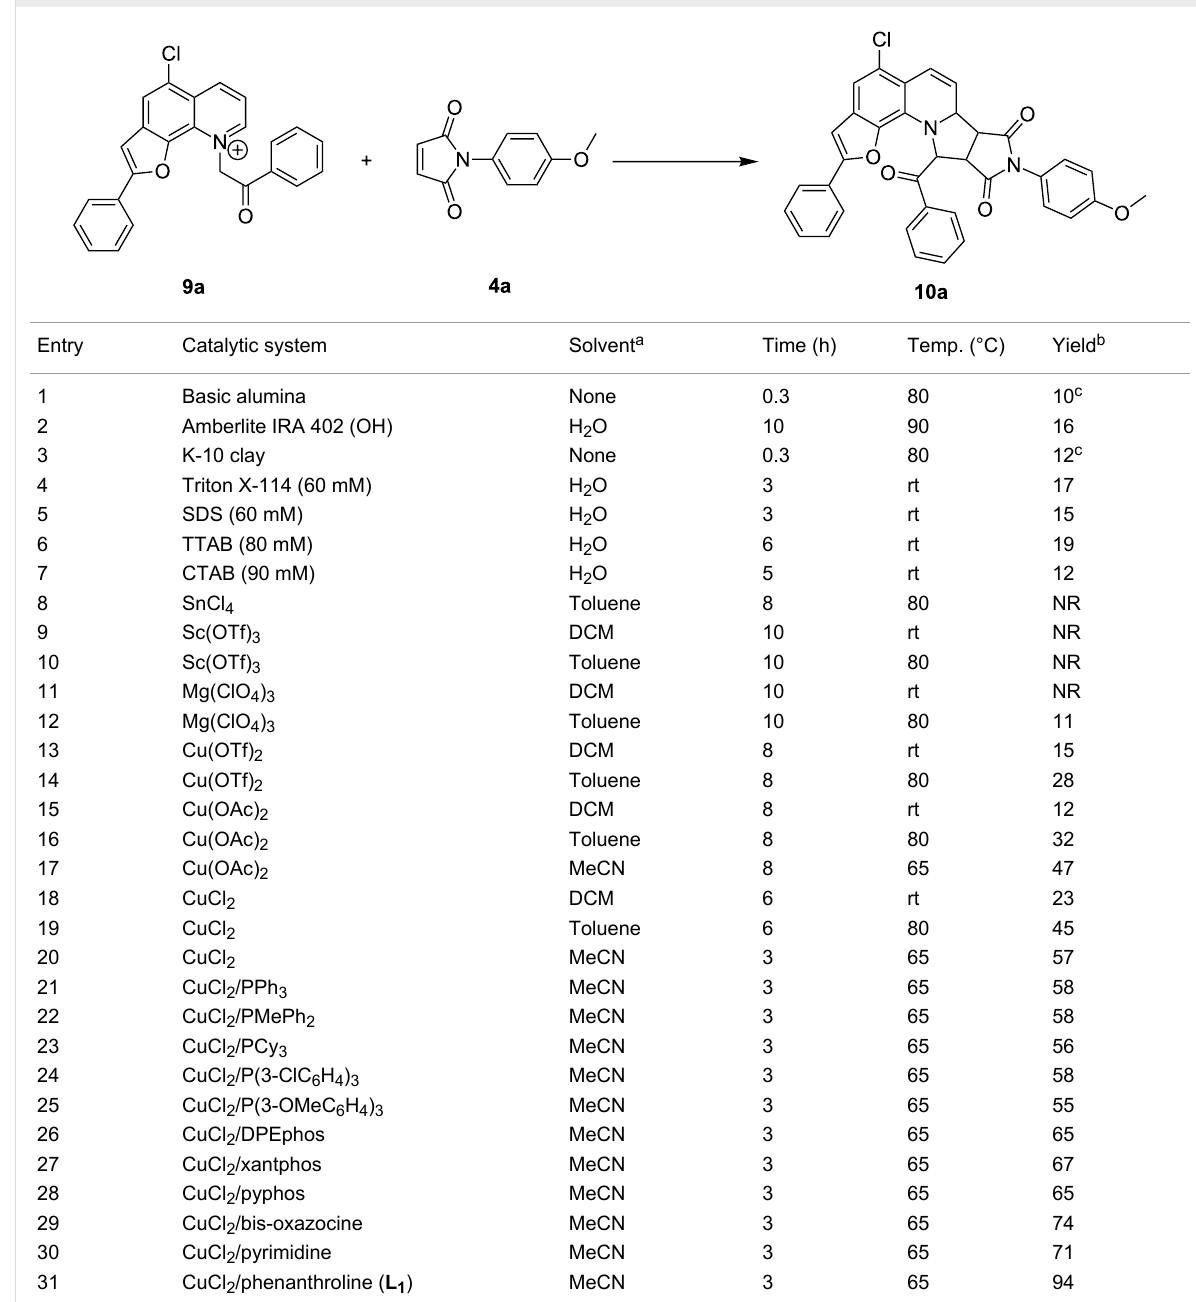
Table 1: Optimization of conditions of reaction between 4a and 9a